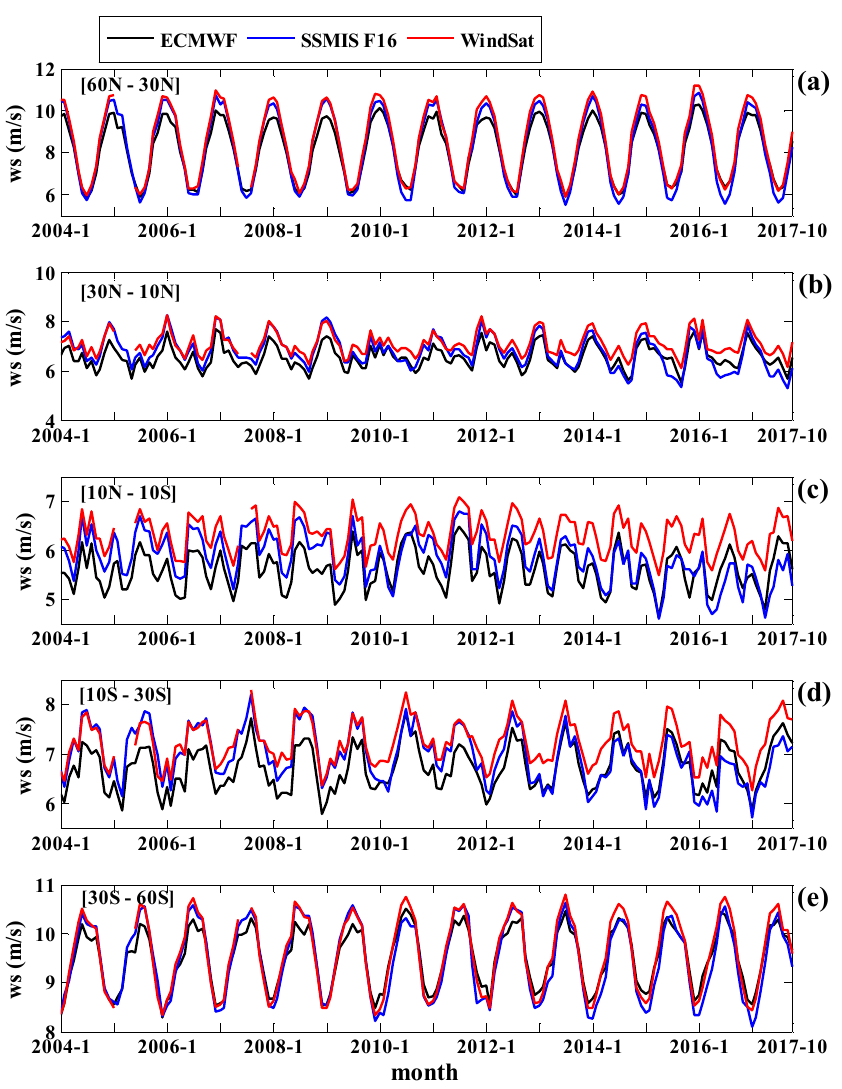
Figure 6. Monthly averaged wind speeds for WindSat (red solid line), SSMIS F16 (blue solid line) and ECMWF (black solid line) in five latitudinal bands: ( a ) 30°N–60°N; ( b ) 10°N–30°N; ( c ) 10°S–10°N; ( d ) 10°S–30°S; and ( e ) 30°S–60°S. Time periods range from January 2004 to October 2017.